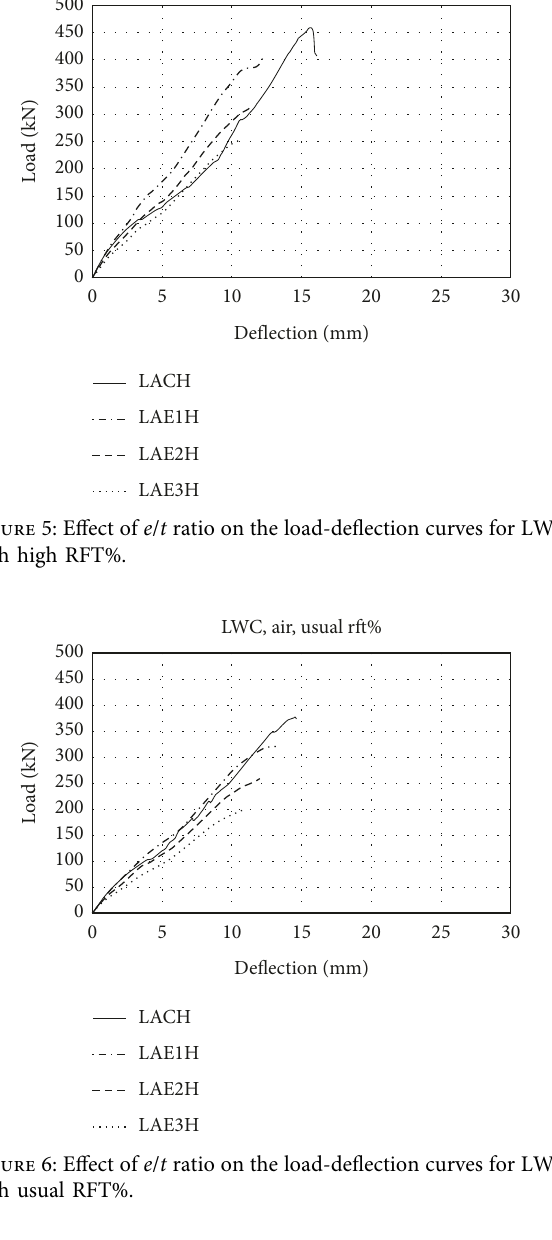
Figure 8: Effect of e/ t ratio on the maximum deflection for